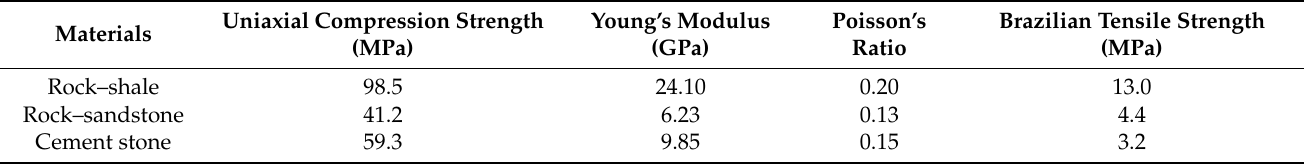
Table 1. Basic mechanical parameters of selected rock and cement stone.